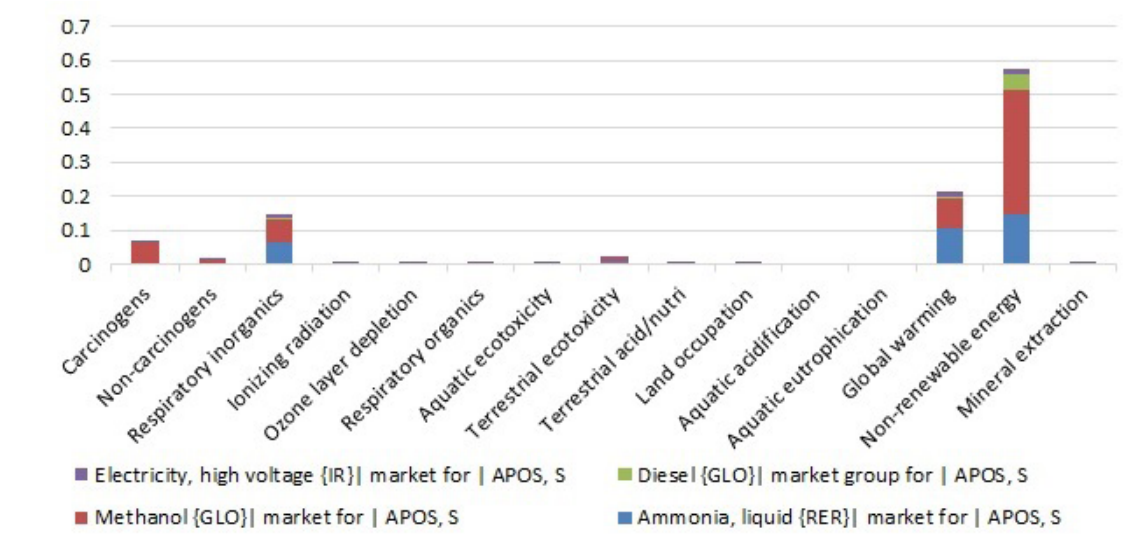
Figure 13. Results of applying normalization coefficients of the IMPACT 2002+method in calculating impacts